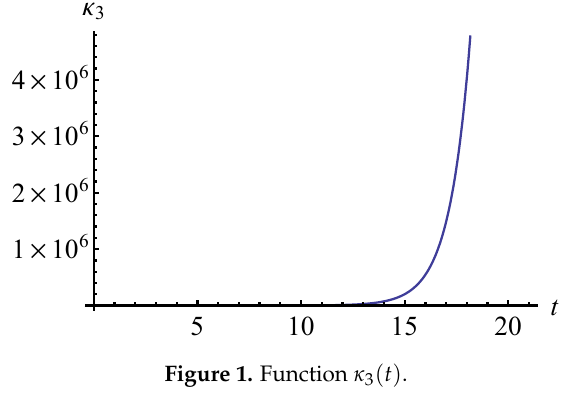
Figure 1. Function κ 3 ( t )